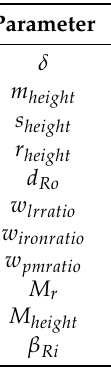
Table 2. Constant parameters in the topology choice and for